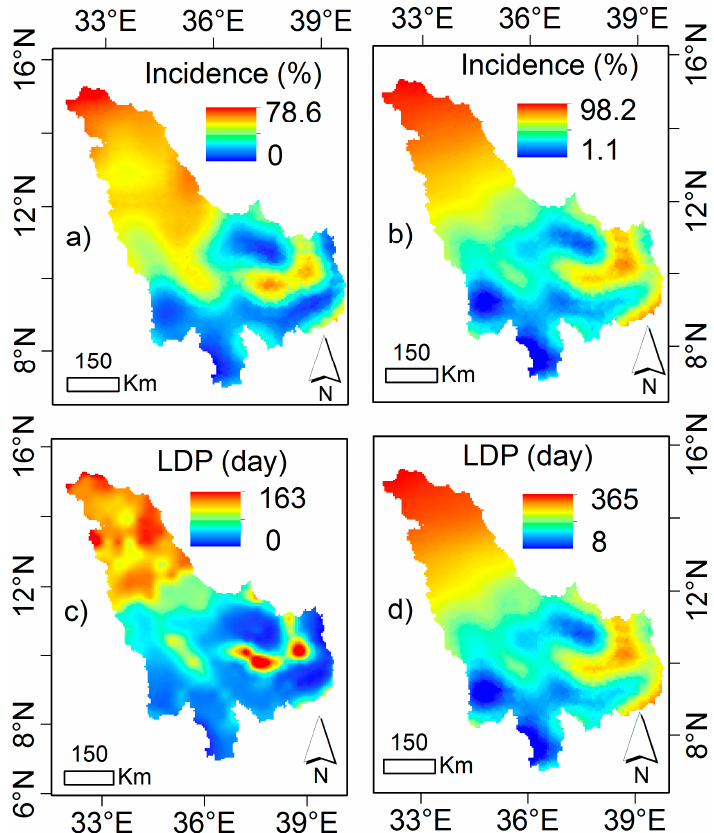
Figure A6. Historical: ( a , b ) incidence (%); and ( c , d ) LDP (day) of the precipitation insufficiency based on threshold of: ( a , c ) − 10 mm/day; and ( b , d ) − 5 mm/day, considering the period 1979–2000.